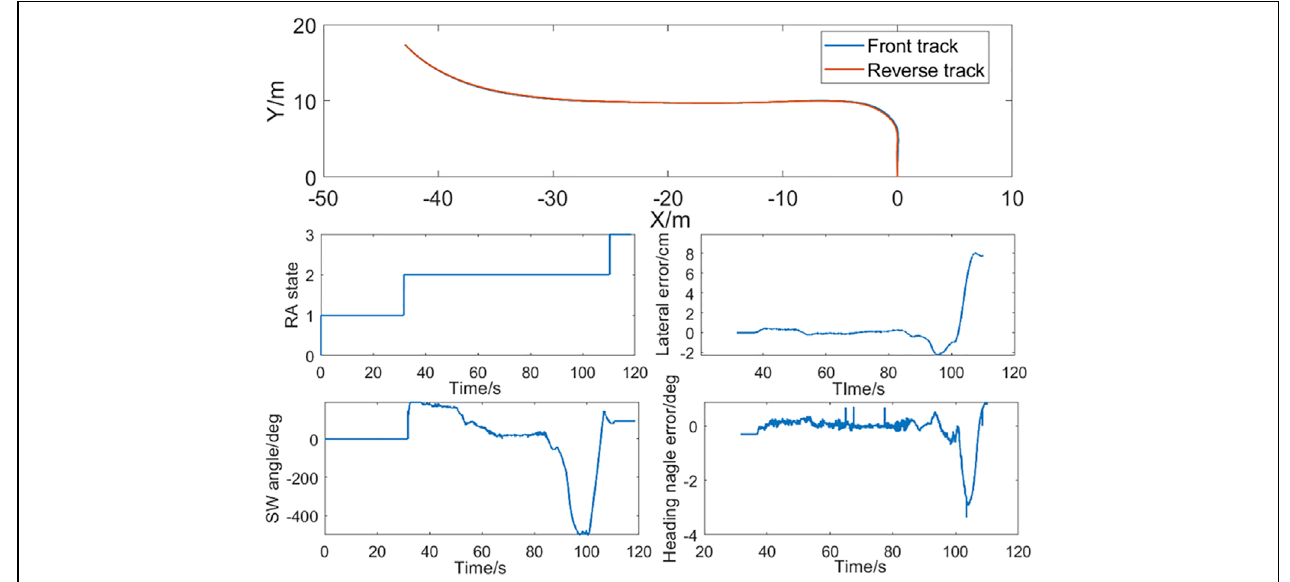
FIGURE 13 | RA in a